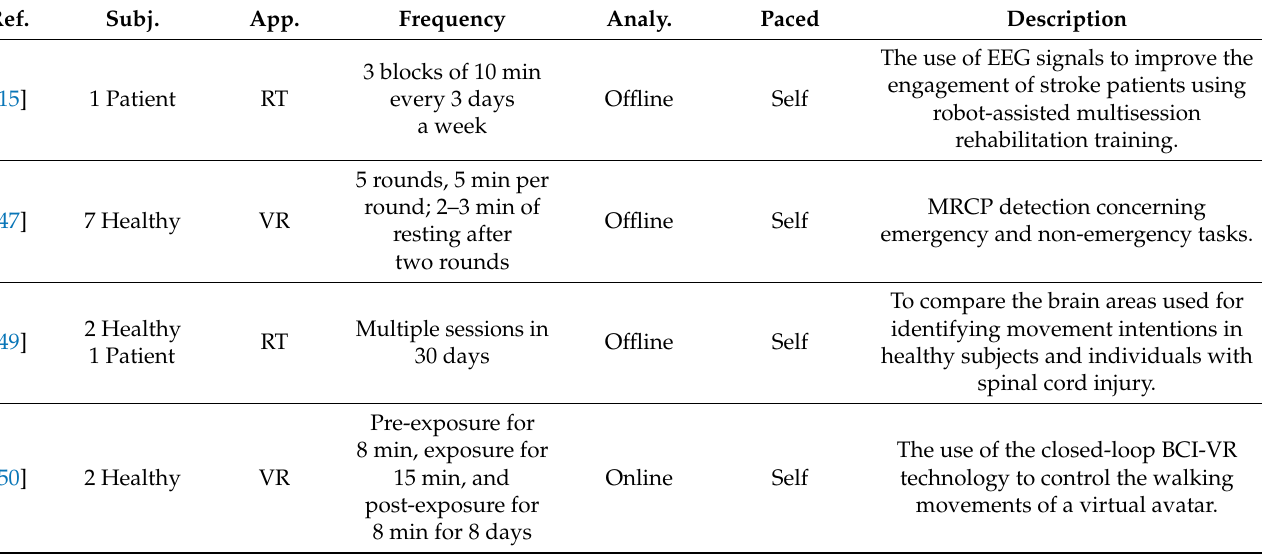
Table 4. Previously published papers evaluated based on subject, application, frequency, analysis, pace, and study